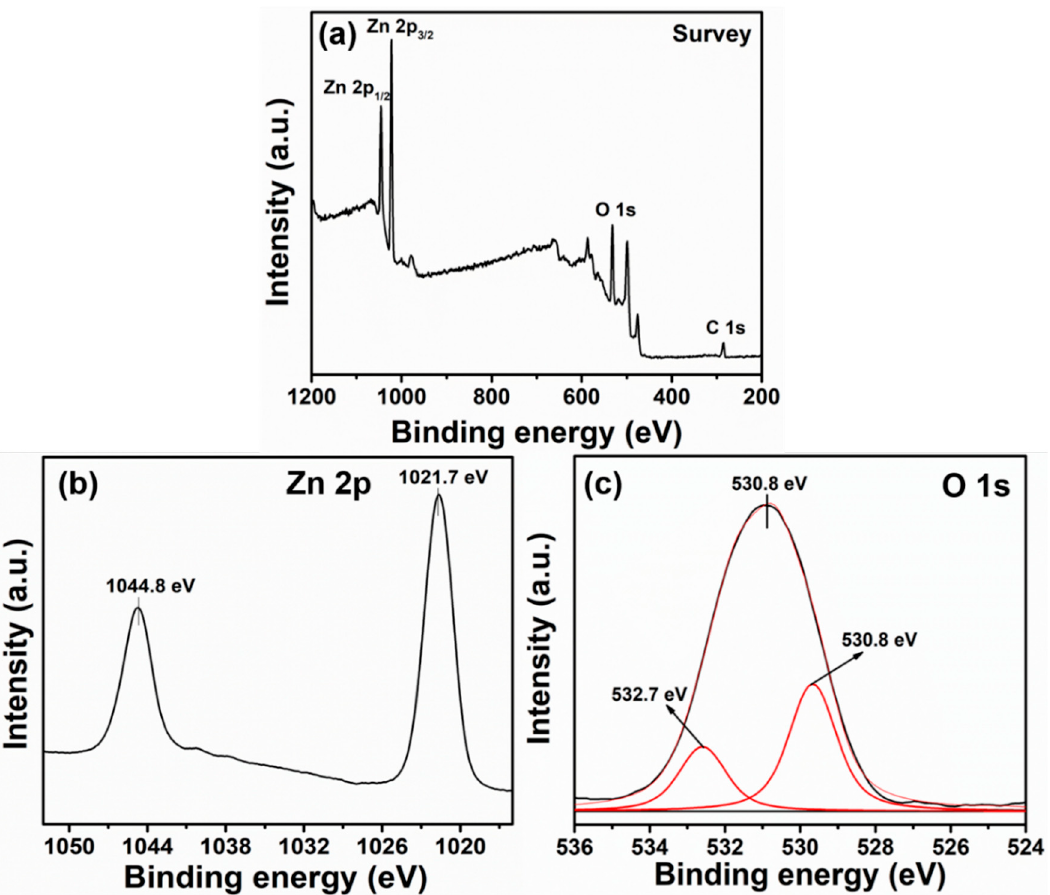
Figure 5. Typical XPS ( a ) full survey, ( b ) Zn 2p, and ( c ) O1s spectrum of flower-shaped ZnO nanostructures directly grown on FTO substrate.